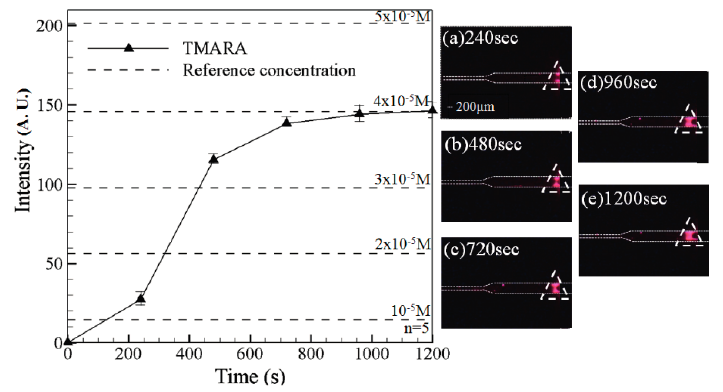
Figure 8. Fluorescence intensity curves of TAMRA ( Left ) and corresponding experimental images at 240 s, 480 s, 720 s, 960 s and 1200 s ( Right ). Note that driving voltage is 100 V. Data points represent the mean of five measurements, and the error bars represent one standard deviation from the